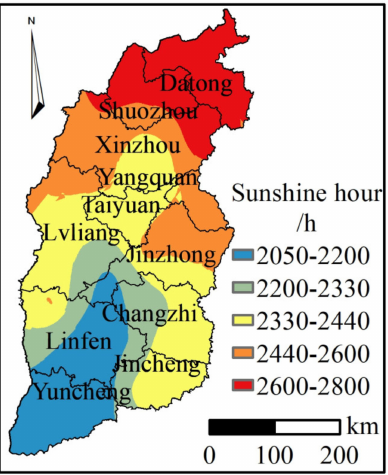
Figure 5. Spatial distribution of annual sunshine hours in Shanxi province.